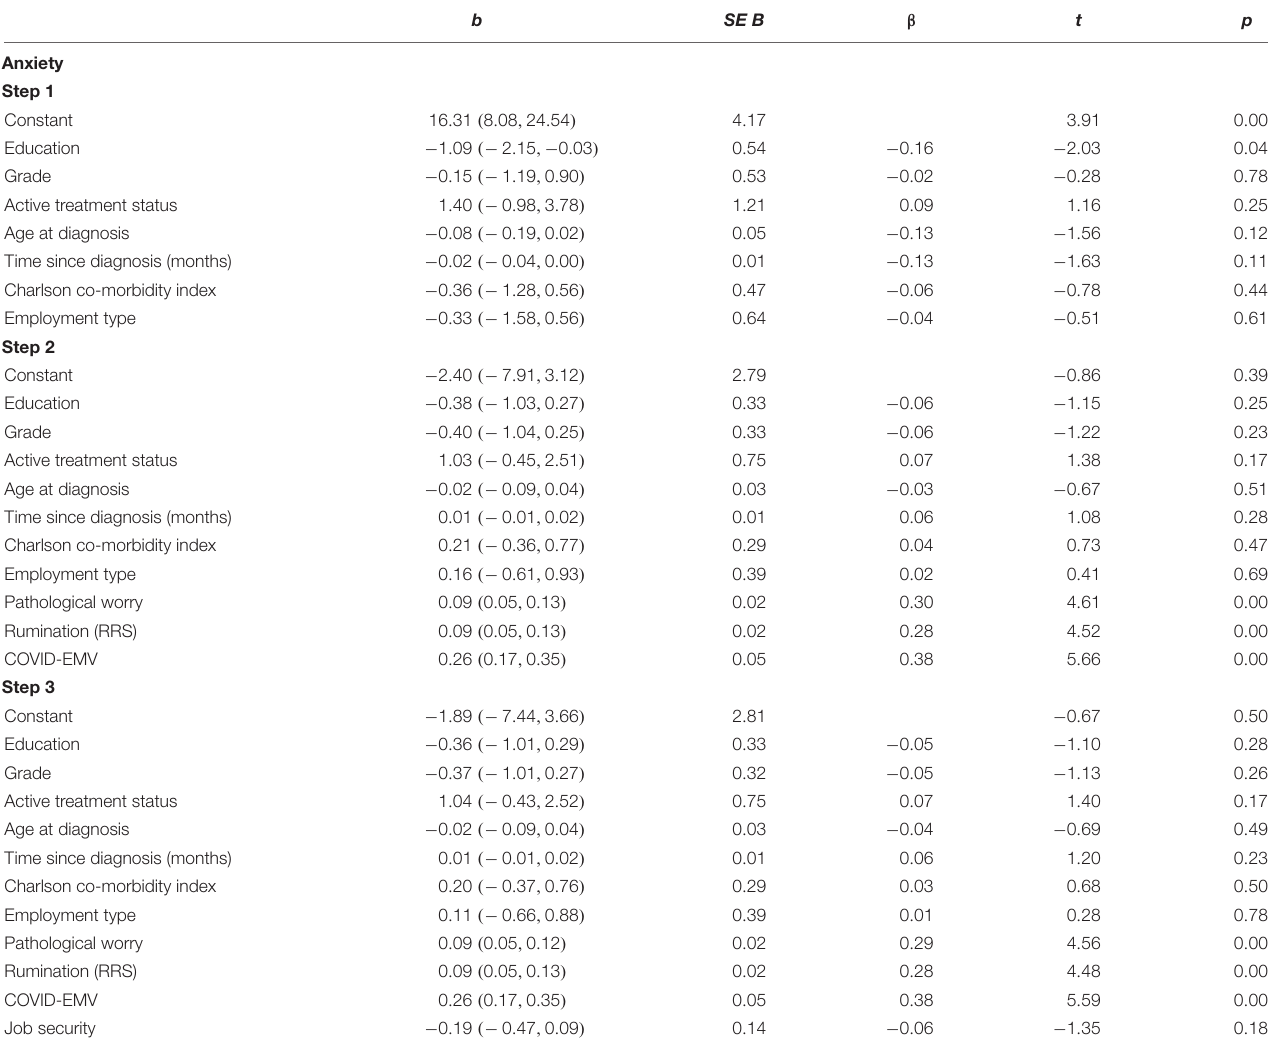
TABLE 4 | Hierarchical regression for the predictors of anxiety.